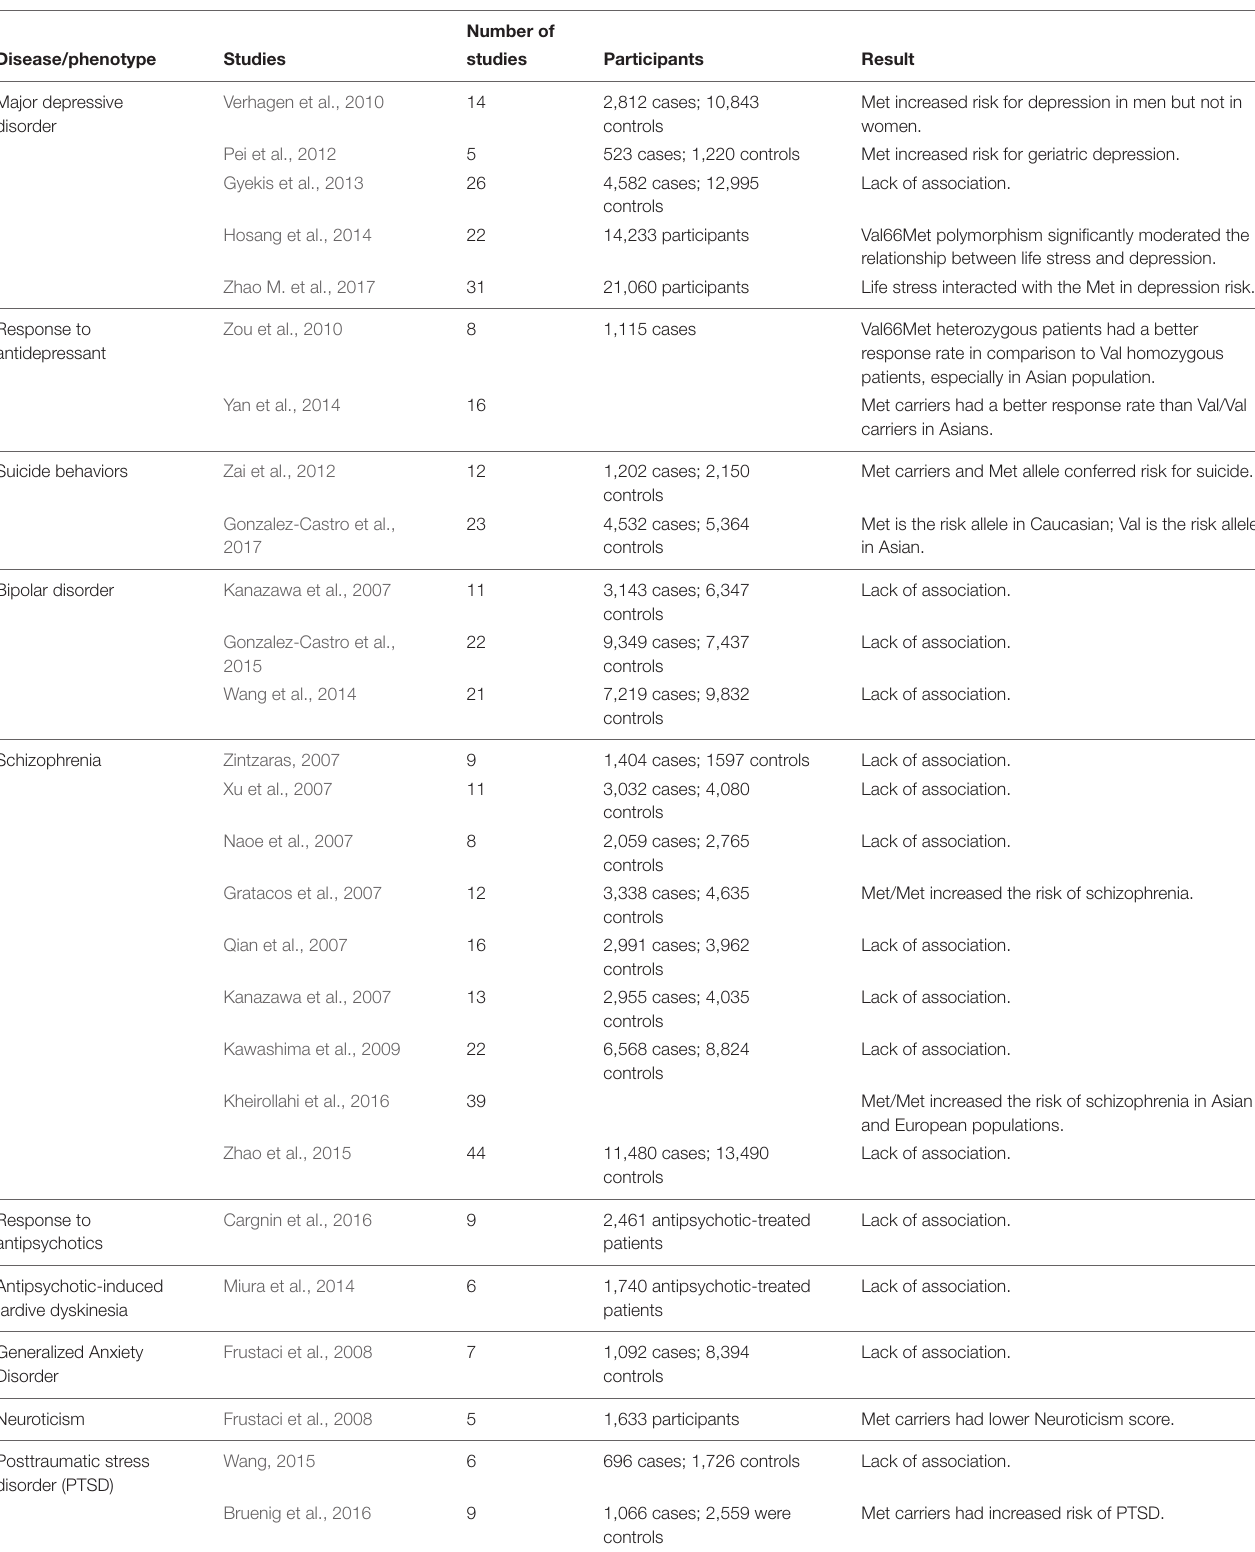
TABLE 1 | Meta-analyses of studies of the BDNF Val66Met polymorphism in neuropsychiatric